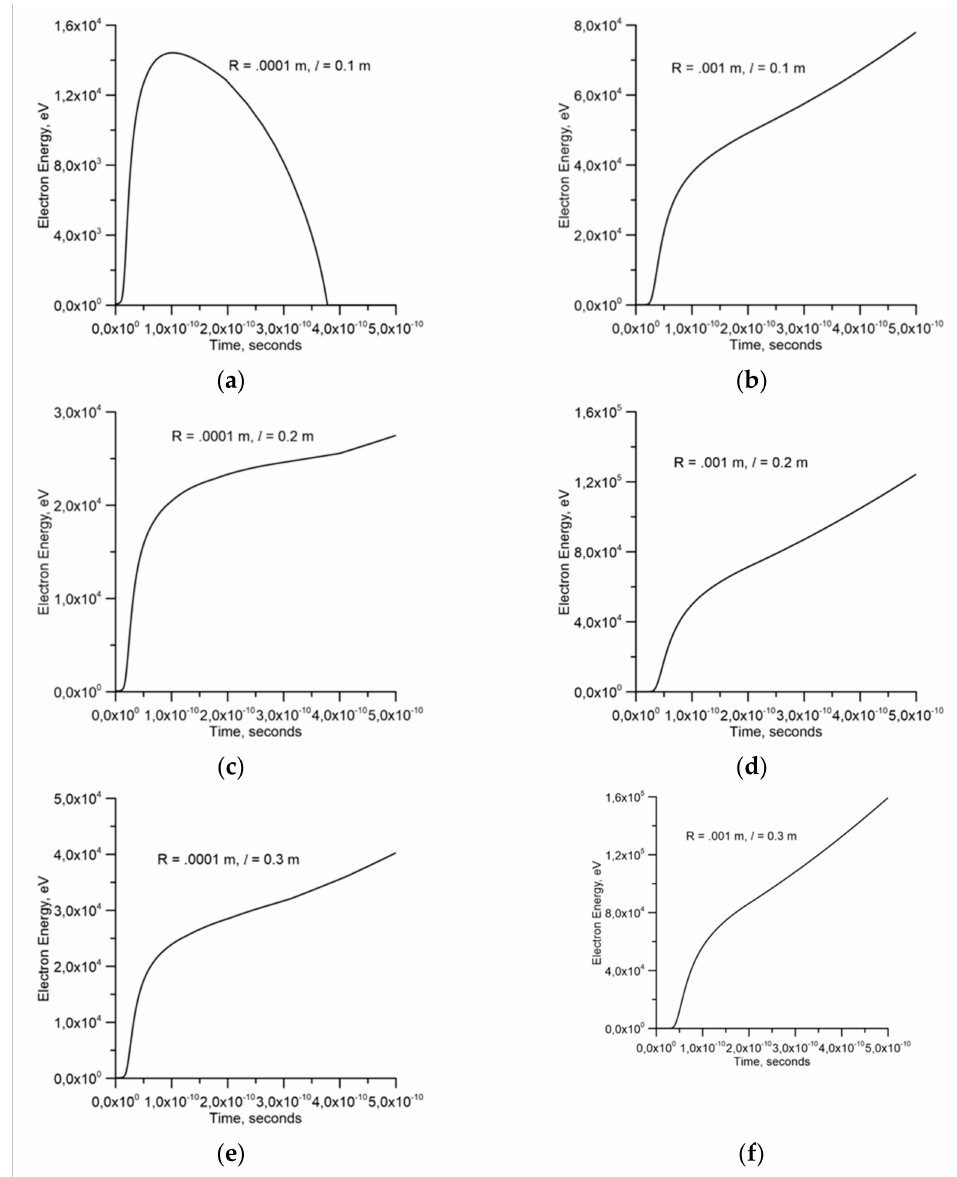
Figure 5. The energy acquired by the accelerating electron as a function of time. In the calculations, it is assumed that the background electric field that polarizes the ionization wave is 10 6 V/m. The speed of the ionization wave is 10 7 m/s. Results are presented for different lengths of the ionization wave and the radius of the channel. ( a ) R = 0.0001 m, l = 0.1 m; ( b ) R = 0.001 m, l = 0.1 m; ( c ) R = 0.0001 m, l = 0.2 m; ( d ) R = 0.001 m, l = 0.2 m; ( e ) R = 0.0001 m, l = 0.3 m and ( f ) R = 0.001 m, l = 0.3